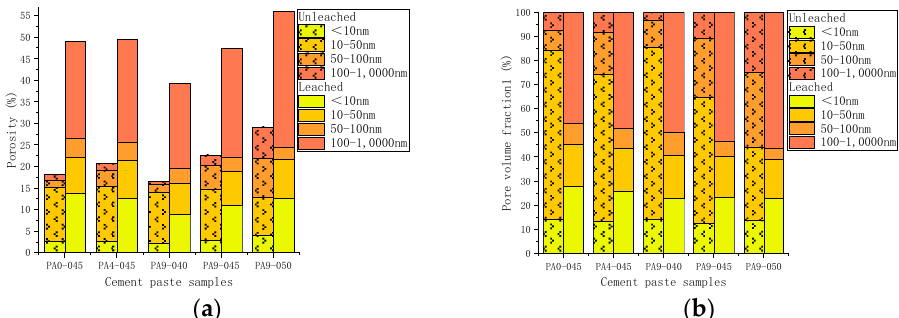
Figure 20. The pore distribution of the unleached and leached cement pastes: ( a ) the porosity; ( b ) the pore volume fraction.